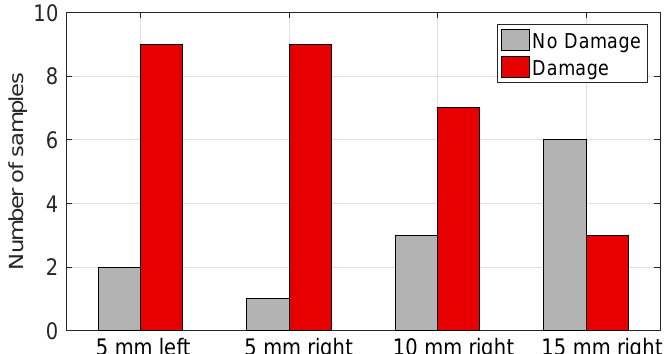
Figure 11. Histogram showing the histological outcomes for thermal damage assessment. The bars show the number of cases at each measurement location exhibiting damage versus not exhibiting damage in the histological analysis. The 12 samples of 100% adipose tissue are not reported here, since their damage state cannot be assessed via histological analysis.